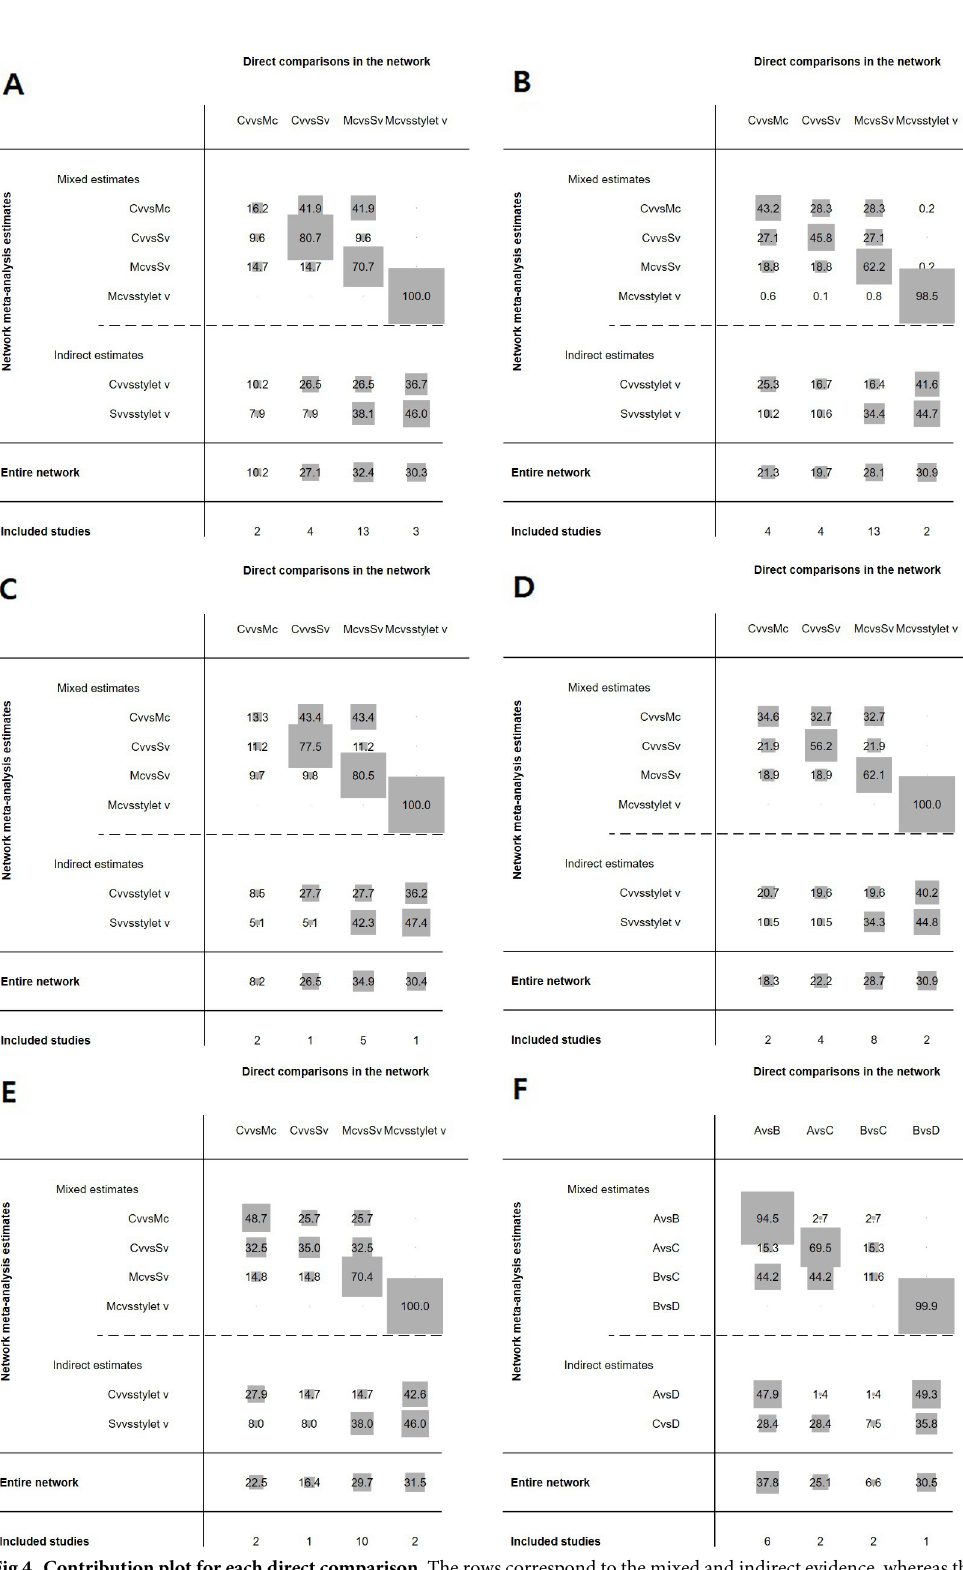
PLOS ONE | https://doi.org/10.1371/journal.pone.0238060 August 28,